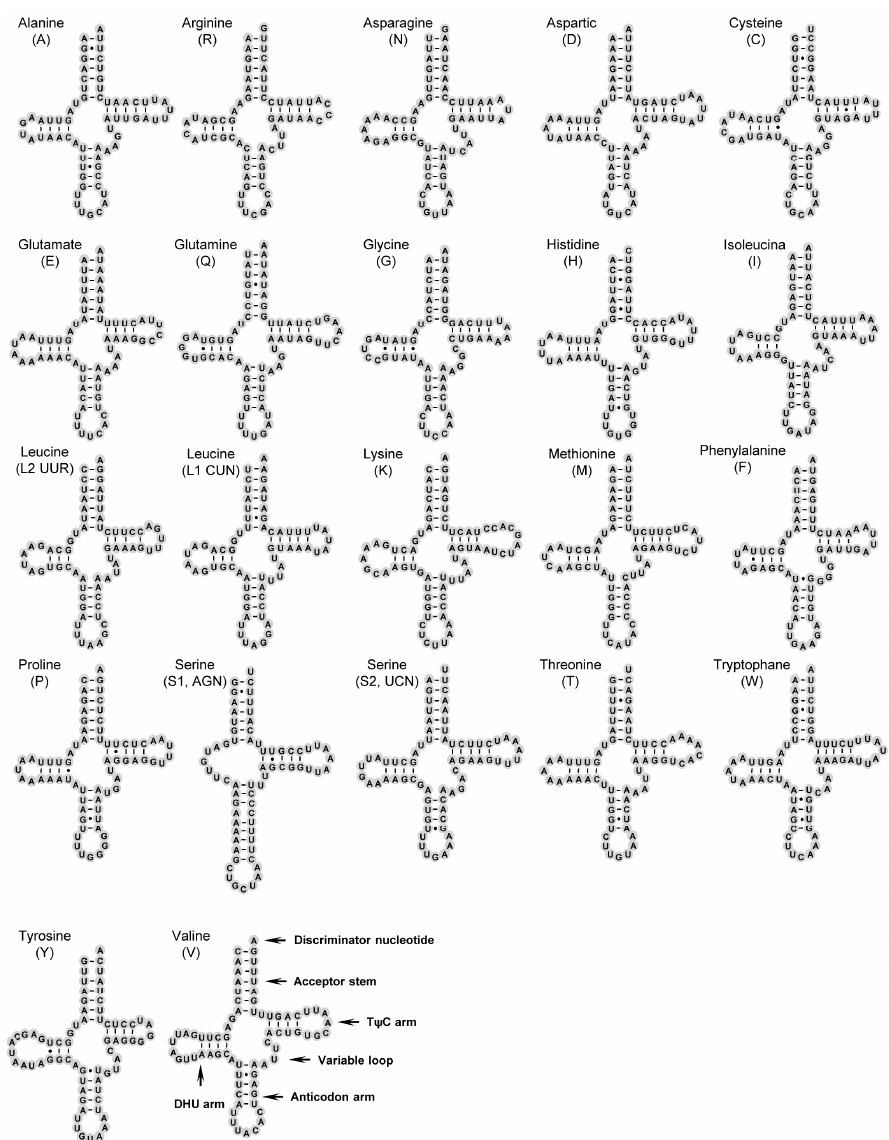
Figure 2. Secondary structures of 22 tRNAs of S. teleckojensis . All tRNAs are labeled with the abbreviations of their corresponding amino acids. Dashes (–) indicate Watson − Crick base pairing and dots ( • ) indicate G − U base pairing.